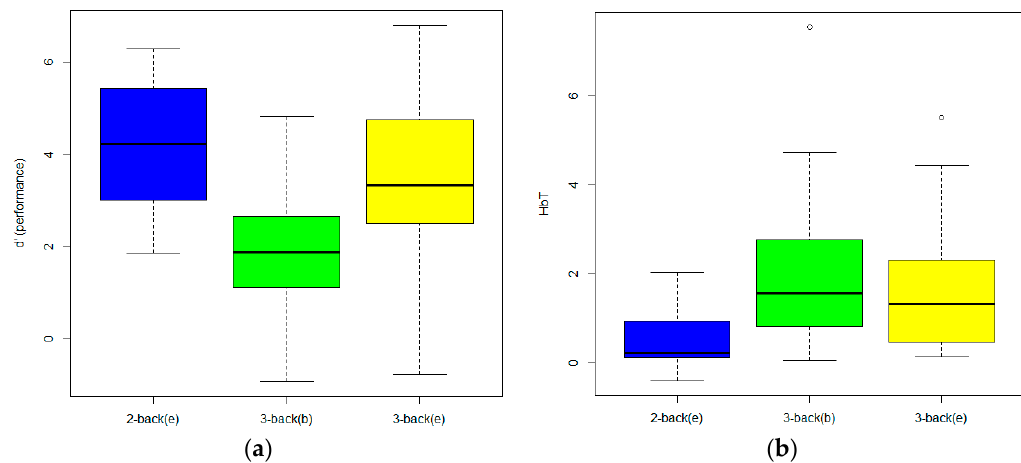
Figure 4. Difference in performance ( a ) and global prefrontal hemodynamic activity ( b ) between tasks .